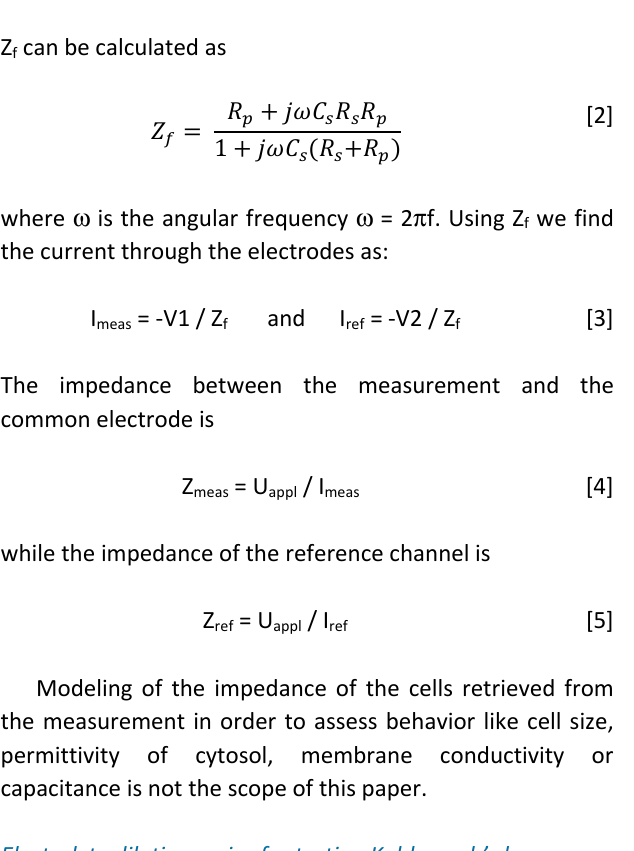
Fig.3: Feedback impedance Z f,1 = Z f,2 = Z f used for the transimpedances in